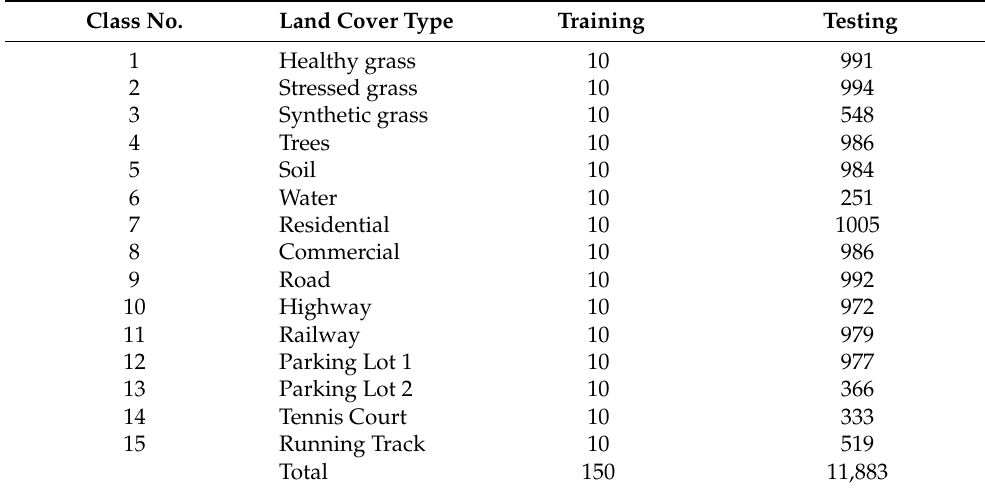
Table 4. The number of training and testing samples in the Houston 2013 dataset. Class No. Land Cover